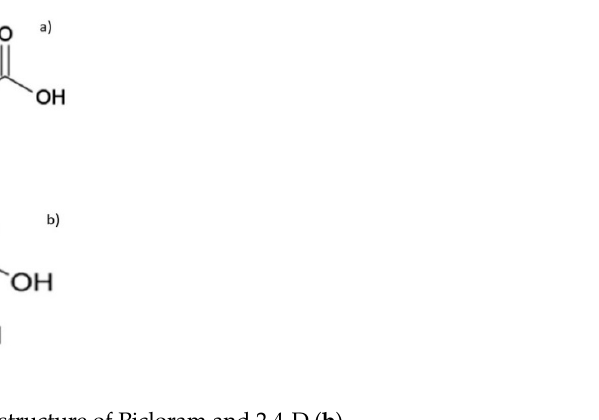
Figure 1. ( a ) Chemical structure of Picloram and 2,4-D ( b ).